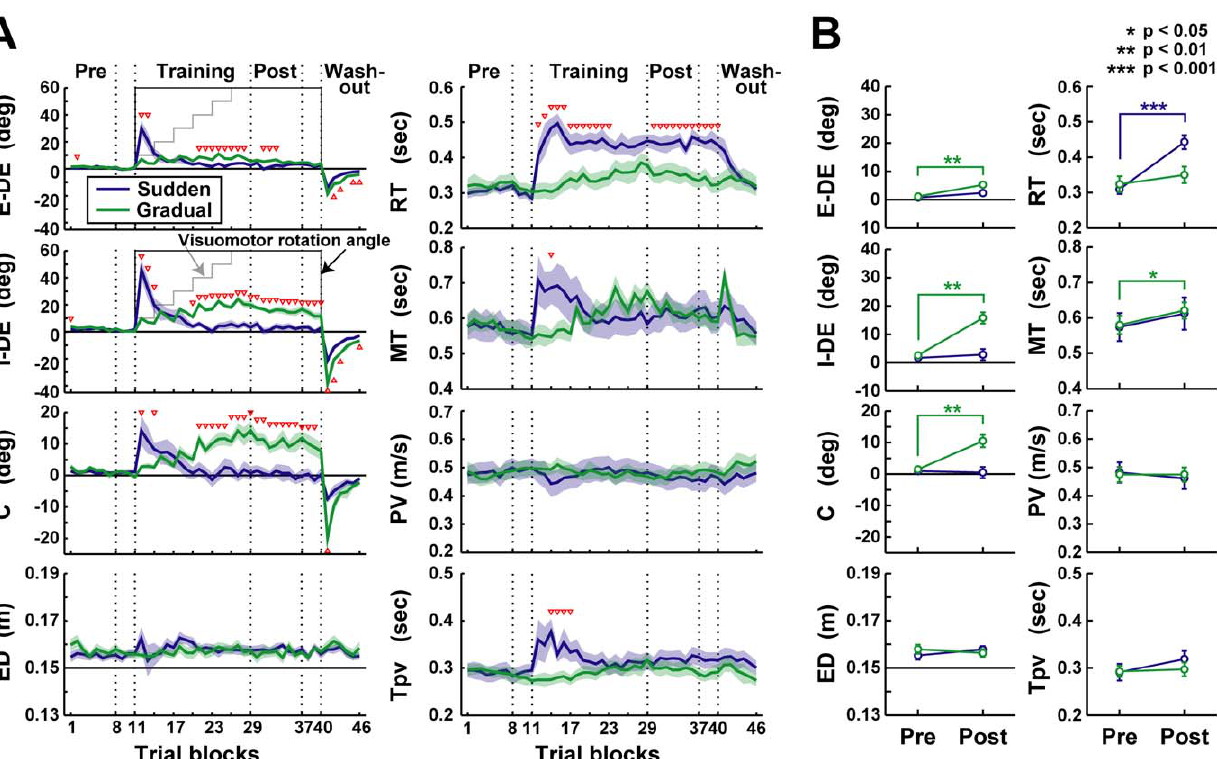
Figure 2. Changes in reaching movement characteristics by the sudden and gradual visuomotor rotation learning. A , Mean characteristics indices of reaching movement across subjects as a function of trial block in experiment 1. Thick blue and green lines in each panel indicate the sudden and gradual conditions, respectively. The visuomotor rotation angles (black and gray thin line for the sudden and gradual conditions, respectively) are superimposed on the panels of the E-DE and I-DE. Shaded areas represent the SE. Open red triangles indicate the trial blocks in which the indices were significantly different between the sudden and gradual conditions ( t test, p , 0.05). B , Changes in the averaged indices between pre- and post-training phases. In all panels, the asterisks (*, **, and ***) denote the significance of differences: p , 0.05, p , 0.01, and p , 0.001, respectively. Error bars represent the SE.